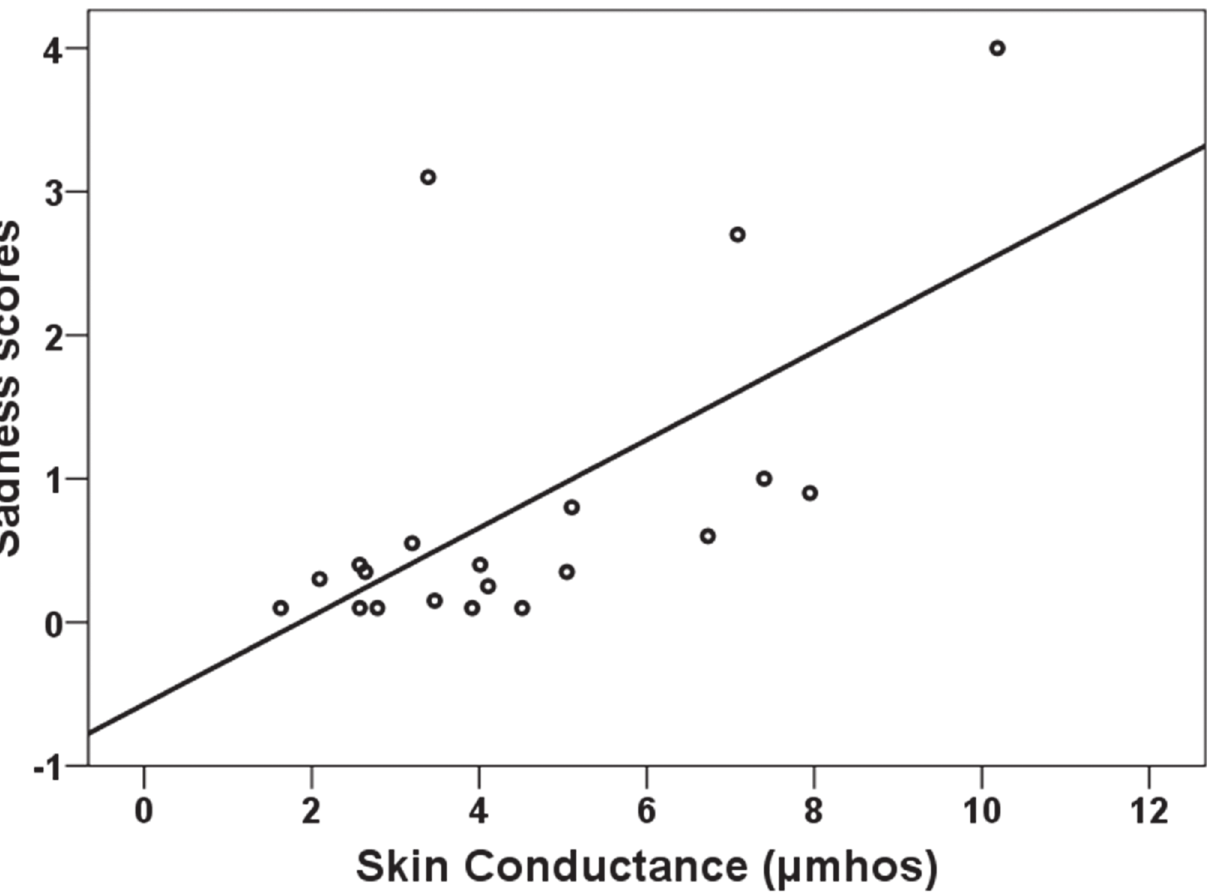
Fig 4. Sadness and skin conductance (SC). Scatterplot and regression line for the relationship between sadness scores and averaged SC in the low body dissatisfaction group during exposition trial